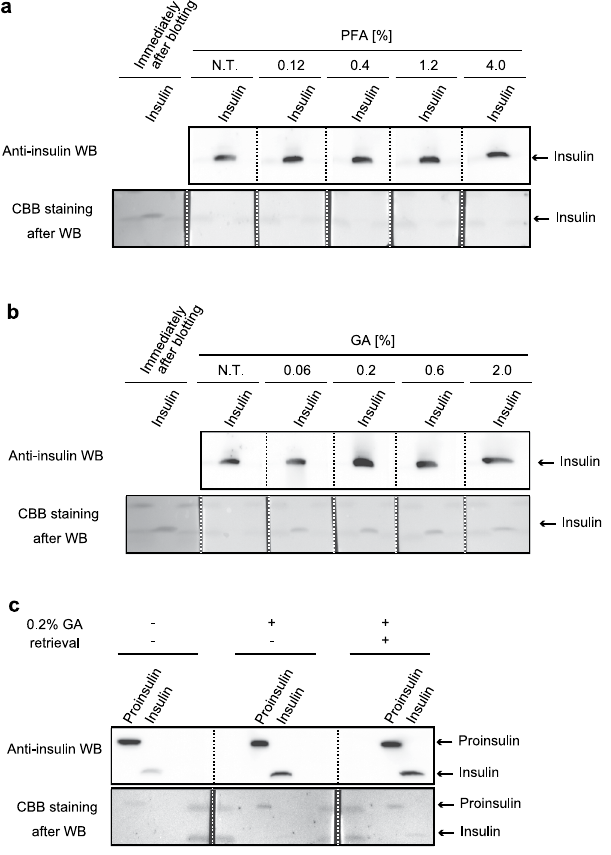
Figure 3. Glutaraldehyde efficiently fixes insulin on the blotted membrane. ( a,b ) Reference standard of insulin (1 µ g) was subjected to Tris/Tricine/urea SDS-PAGE. After electro-blotting, the one blotted membrane was separated into 1 slip for the control experiment (Coomassie brilliant blue [CBB] staining immediately after electro-blotting, labeled as “Immediately after blotting”) and 5 slips for the aldehyde treatment. Paraformaldehyde (PFA) ( a ) or glutaraldehyde (GA) ( b ) concentrations were verified as shown. N.T. indicates a control treatment. ( c ) Reference standards of proinsulin (200 ng) and insulin (125 ng) were subjected to Tris/ Tricine/urea SDS-PAGE. After electro-blotting, the blotted membrane was separated into 3 slips to verify the effect of the retrieval step on insulin Western blotting (WB). Upper panels are the results of WB of insulin, and the lower panels are the results of CBB staining of the blotted membrane. To compare the effects of various conditions, WB images in each sub-part of the figure were captured at one